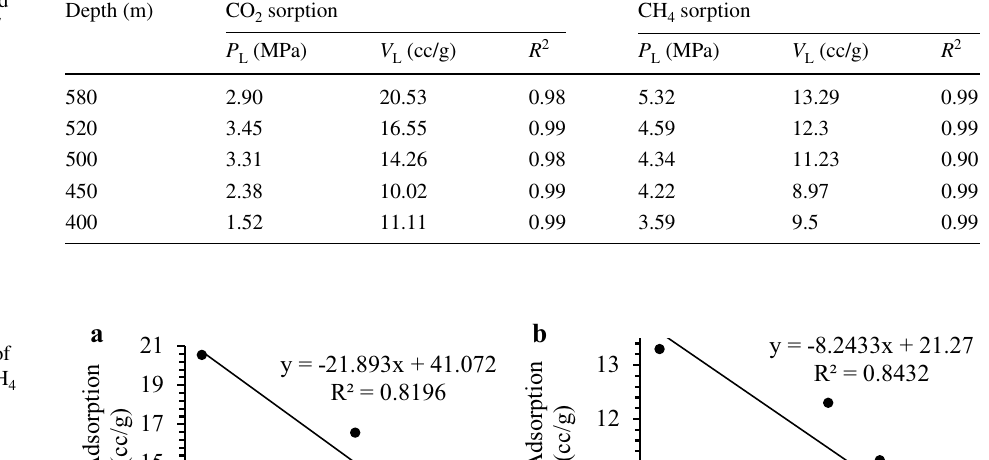
and CH sorption were 2 4